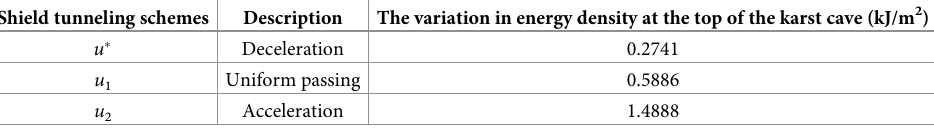
Table 2. Details of the three shield tunneling schemes used in this